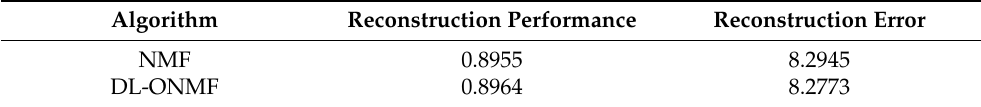
Table 1. Results of algorithm performance comparison.